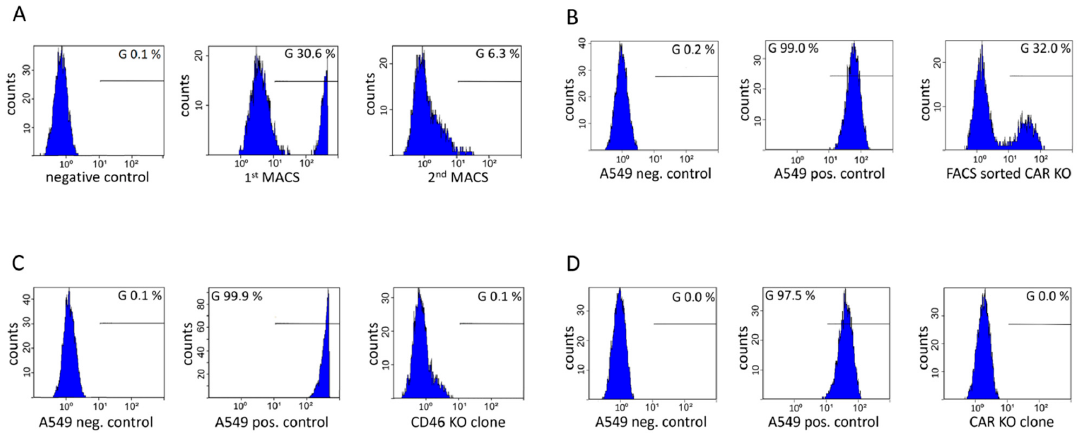
Figure 3. Generation of CD46 and CAR knockout cell lines using cell sorting. ( A ) CD46 protein expression after the first and second round of the MACS procedure. ( B ) CD46 protein expression after cell singularization of the CD46 knockout cells. The chosen clone CD46-KO is displayed. ( C ) CAR protein expression after flow cytometric sorting and ( D ) after cell singularization. The chosen CAR knockout clone, CAR-KO, is displayed. The parental A549 cell line serves as a positive control, incubated with the corresponding primary and secondary antibodies. For the negative control, the parental A549 cells were incubated with the secondary antibody only. All measurements were carried out with the same monoclonal APC-linked secondary antibody.